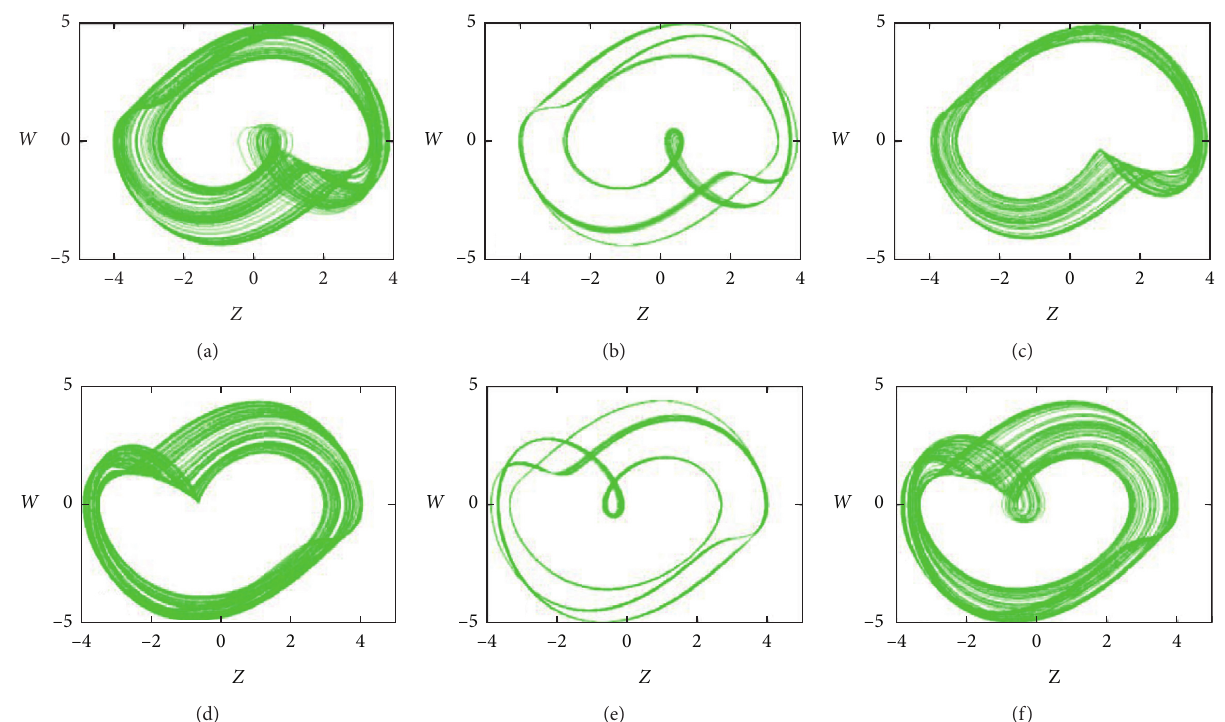
Figure 13: Typical coexisting attractors of system (1) with (a) � 0.8, (b) � 0.5, (c) � 1, (d) � 0.1 and initial condition IC � (0.01, y � -0.15, (b) y �− 0.1185, (c) y 0